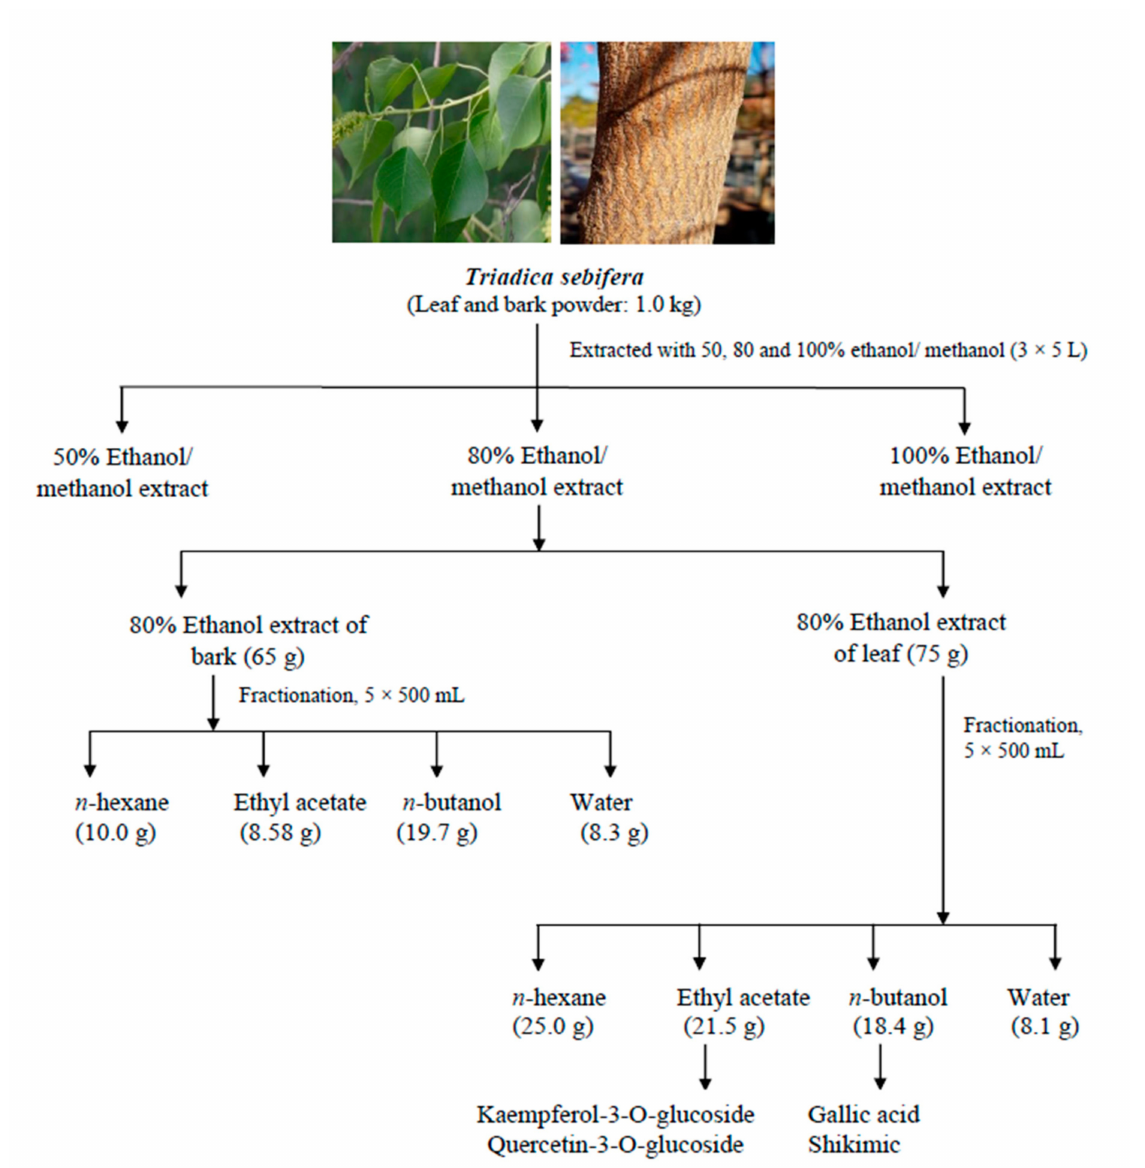
Figure 2. Schematic representation of extraction and fractionation of Triadica sebifera